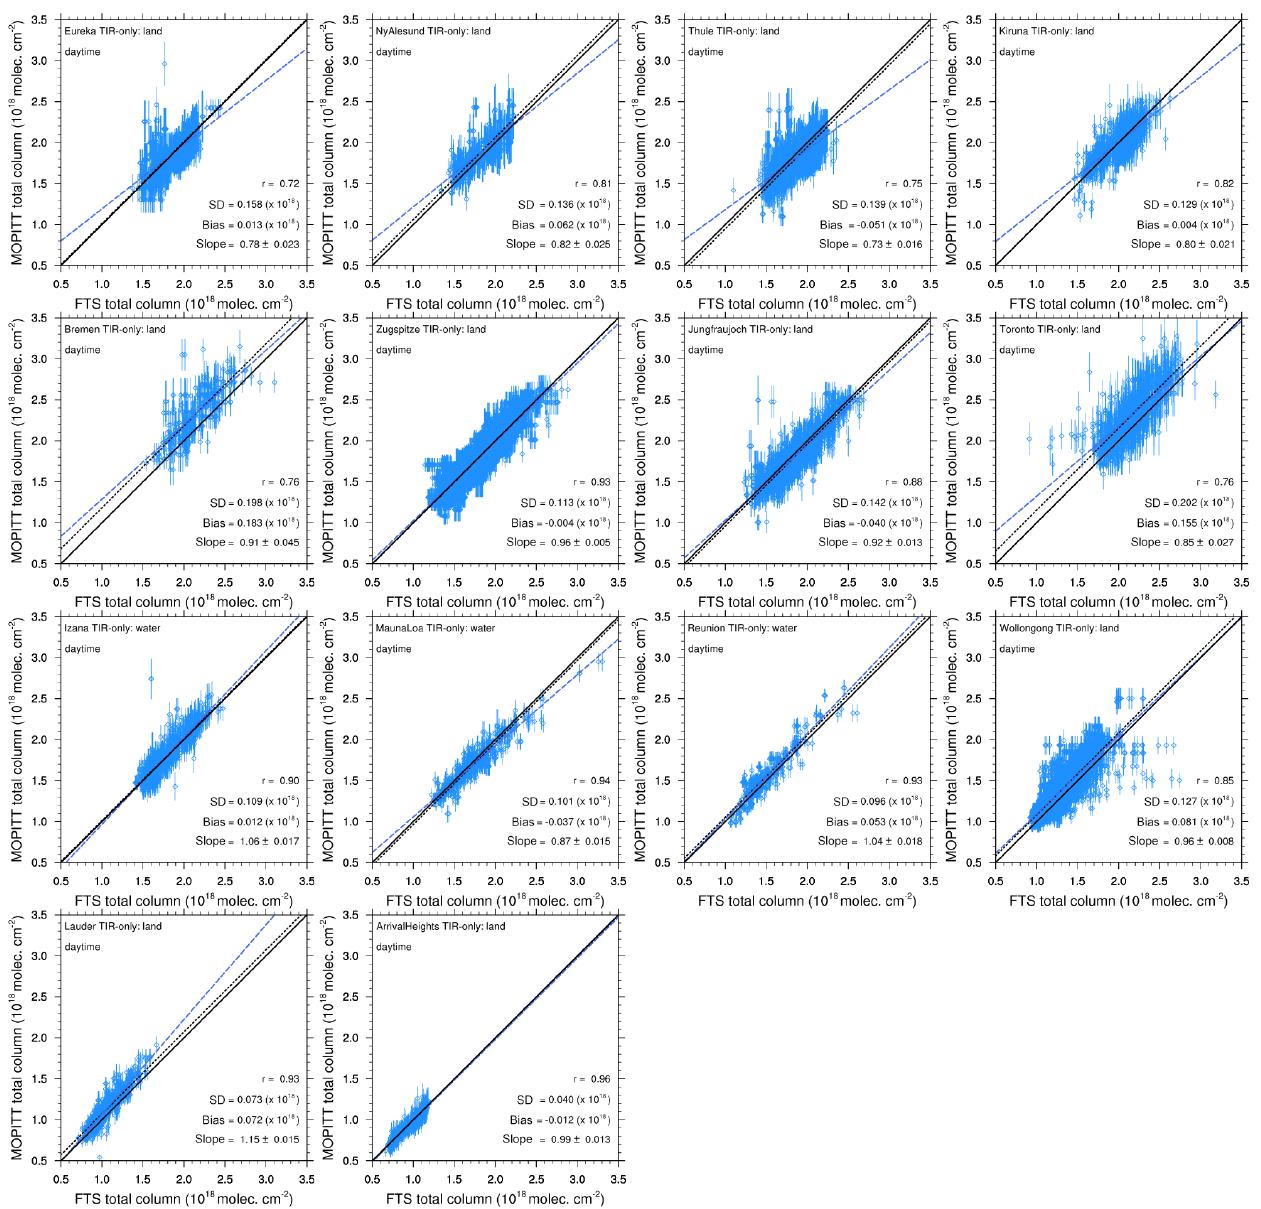
Figure A2. Correlation plot for V6 TIR-only product. The blue dashed line indicates correlation slope, the black dashed line indicates mean bias, and the solid black line is the 1:1 line for comparison. Error bars are the daily combined MOPITT error within a 1 ◦